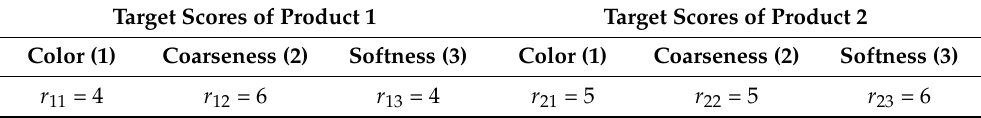
Table 5. Target scores for each